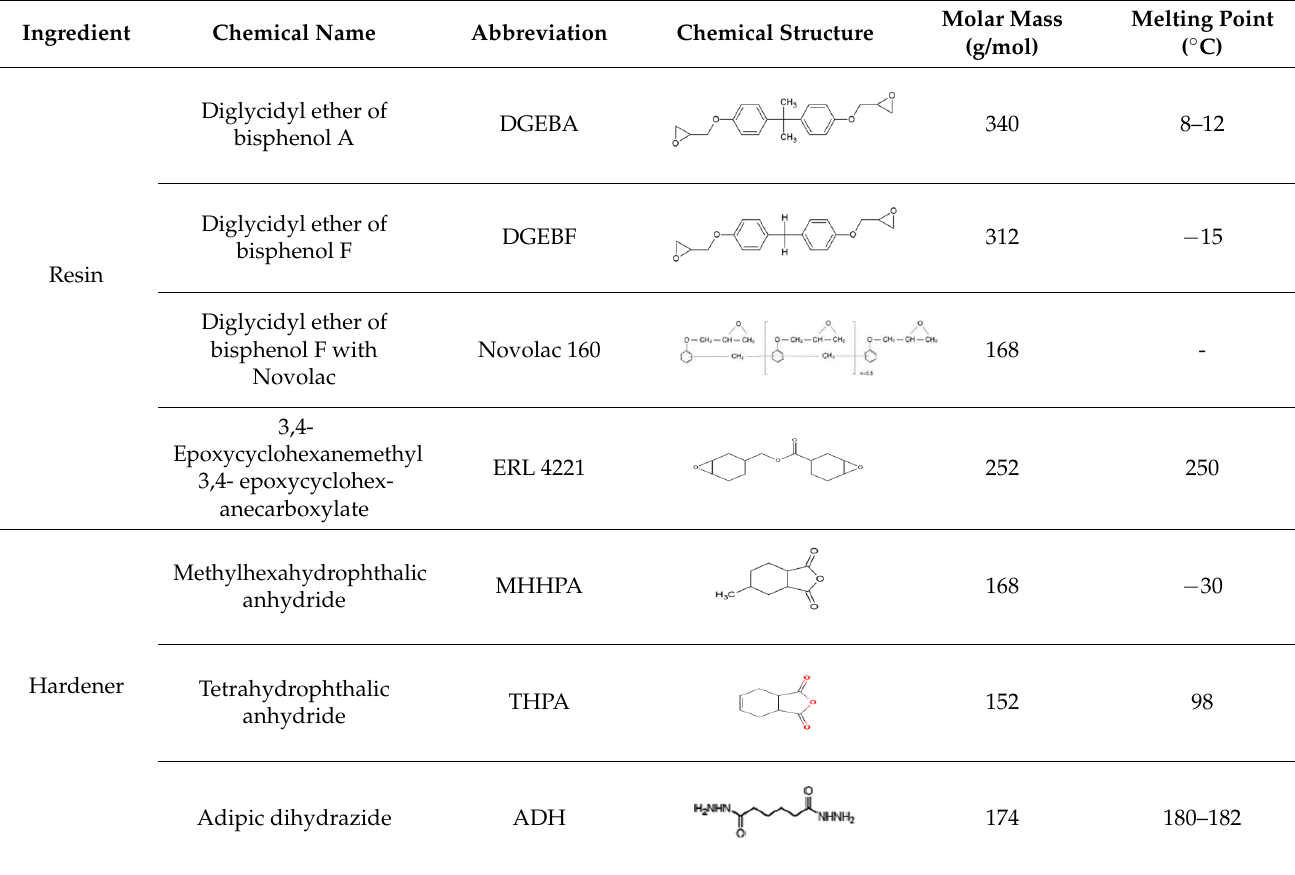
Table 1. Chemical properties of NCA.